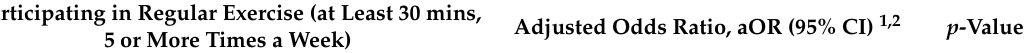
Table 5. Associations between perception of neighborhood environment and regular diabetes screening participation and exercise, amongst residents in two public housing precincts in Singapore, on multivariate analysis ( n =